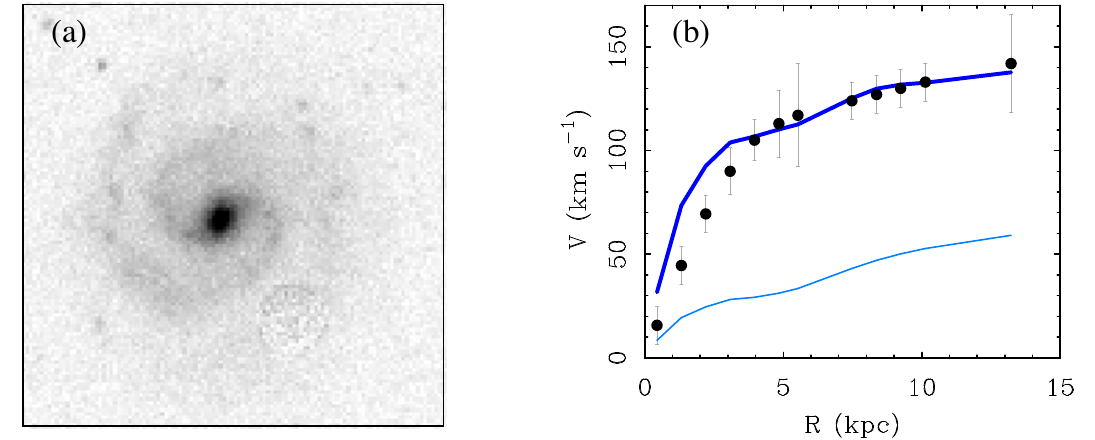
Figure 9. The low surface brightness galaxy F568-1, as seen ( a ) in the V -band [180], together with ( b ) its rotation curve and mass model [29]. The lower blue line is the mass model for the nominal stellar disk with M ∗ ≈ 3 × 10 9 M (cid:12) , which has a [3.6] Υ ∗ = 0.5 M (cid:12) /L (cid:12) and corresponding V -band Υ ∗ = 1.4 M (cid:12) /L (cid:12) . The disk-to-halo ratio is small, so spiral structure should be suppressed [177,178]. The upper blue line shows the disk rotation curve with the mass required to explain the observed spiral structure in ( a ) in the context of dark matter [187]. The stellar disk must be very heavy: M ∗ ≈ 42 × 10 9 M (cid:12) , with Υ ∗ = 6.7 M (cid:12) /L (cid:12) in [3.6] and 20 M (cid:12) /L (cid:12) in the V -band. This is well in excess of the mass expected for a stellar population. Indeed, the stellar disk is so heavy that it leaves no room for dark matter and exceeds the observed rotation for R < 3 kpc. Taken at face value, this poses a contradiction for any flavor of dark matter, as predicted by